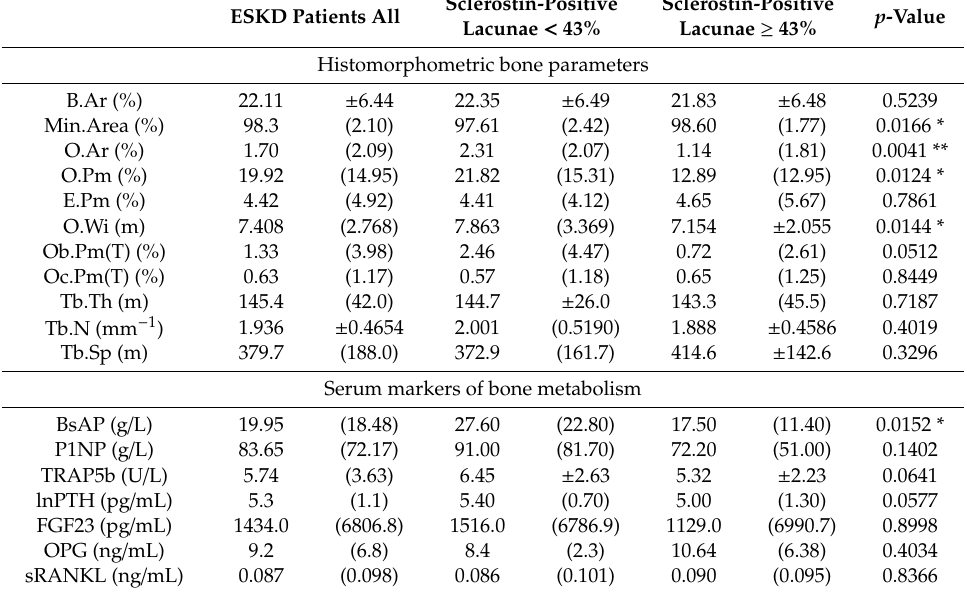
Table 1. Bone histomorphometric parameters and serum markers of bone metabolism of the total end-stage kidney disease (ESKD) cohort and according to the percentage of sclerostin-positive lacunae (i.e., below versus equal or above the median of